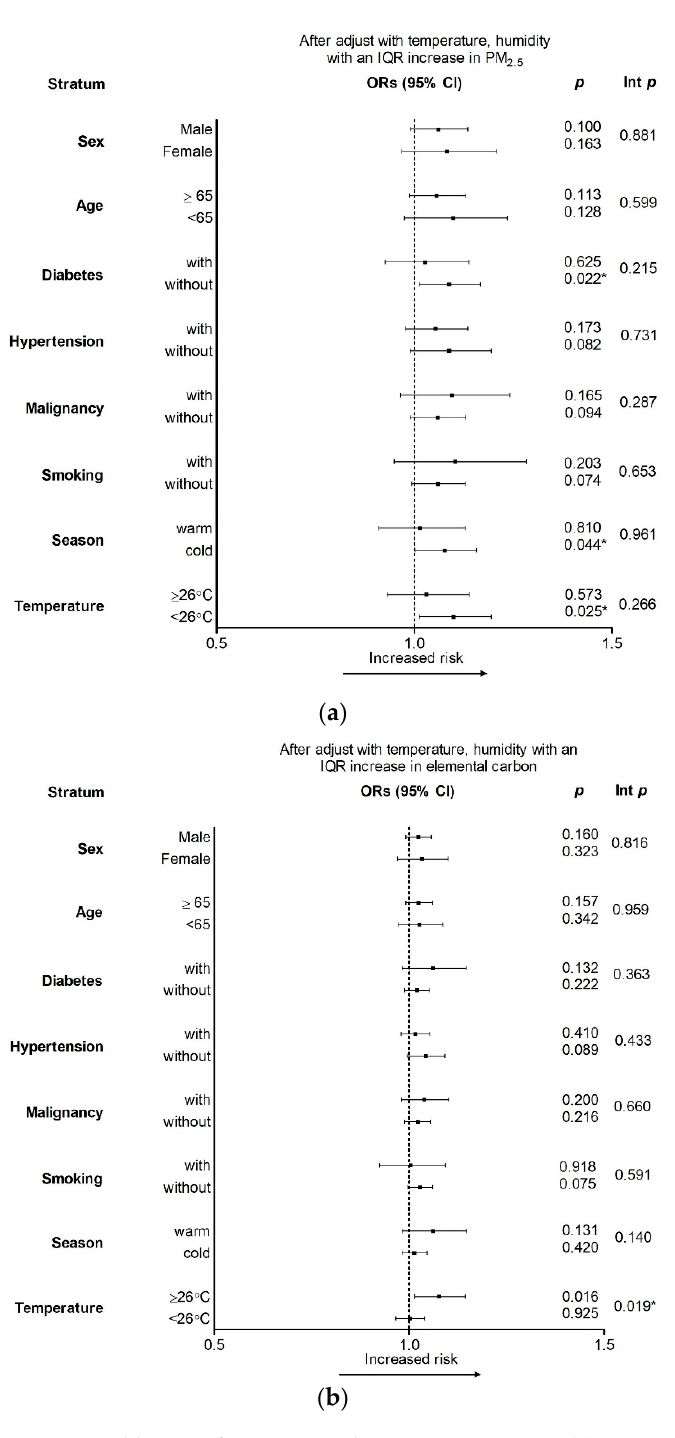
Figure 2. Odds ratios for interquartile range increments in ( a ) PM 2.5 on lag 2 and ( b ) elemental carbon on lag 0 after the adjustment for temperature and humidity. * p < 0.05. COPD, chronic obstructive pulmonary disease; Int p, interaction p value.